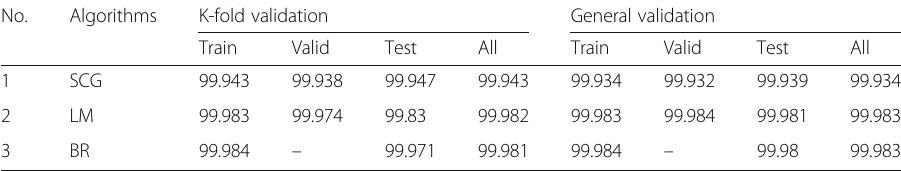
Table 1 Accuracy (in %) comparison between K-fold and General validation for tick data No. Algorithms K-fold validation General